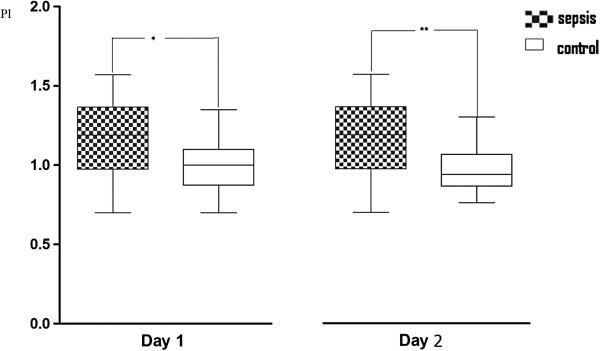
Pulsatility index (PI) on the 2 days.*p = 0.04; **p = 0.01.